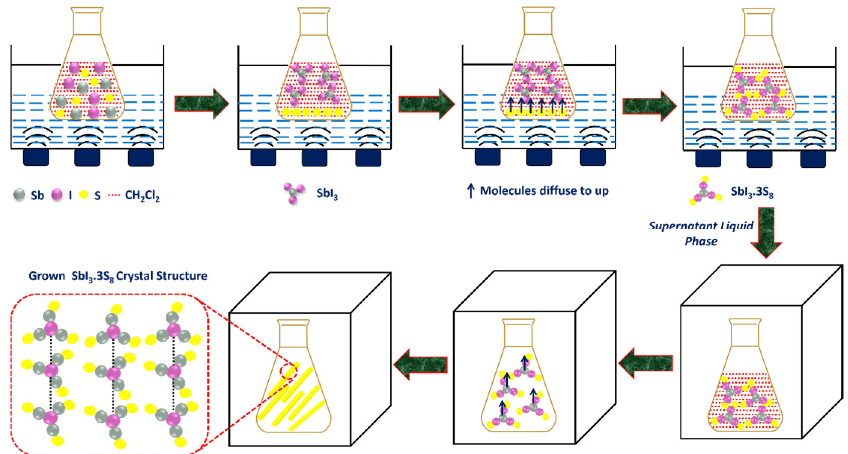
Figure 9. Schematic diagram of the crystal the mechanism of grown SbI 3 •3S 8 crystal starting from raw materials (antimony (Sb), iodine (I), and sulfur (S)) in dichloromethane (CH 2 Cl 2 ) as a solvent medium.